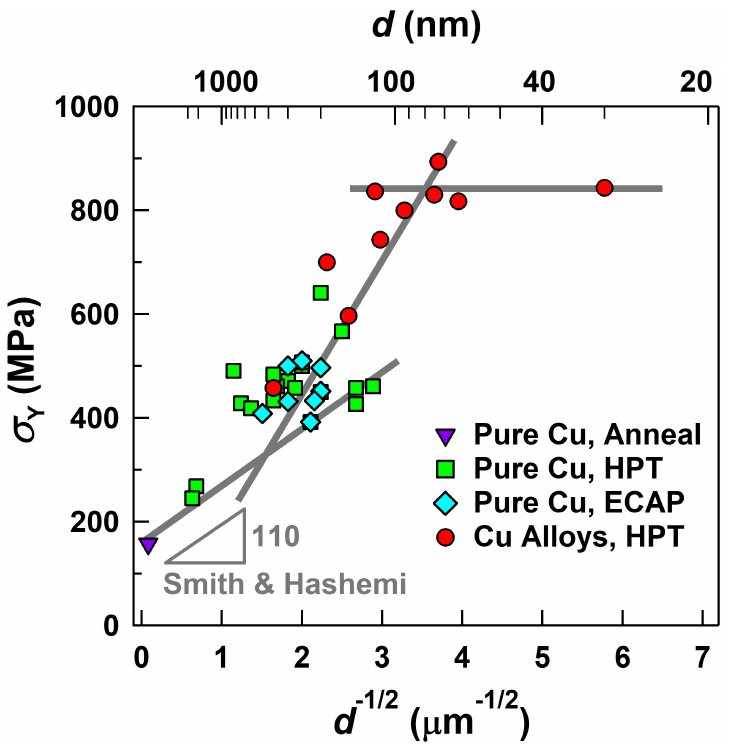
Figure 3. The Hall–Petch plot (yield stress, σ y , versus inverse square root of grain size, d ) and its breaks for copper and its alloys before and after severe plastic deformation by high-pressure torsion (HPT) and equal-channel angular pressing (ECAP).